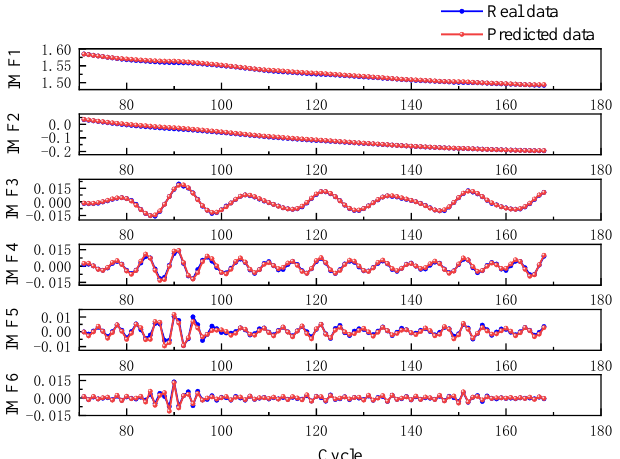
Figure 11. Prediction results of the components of the B5 battery.